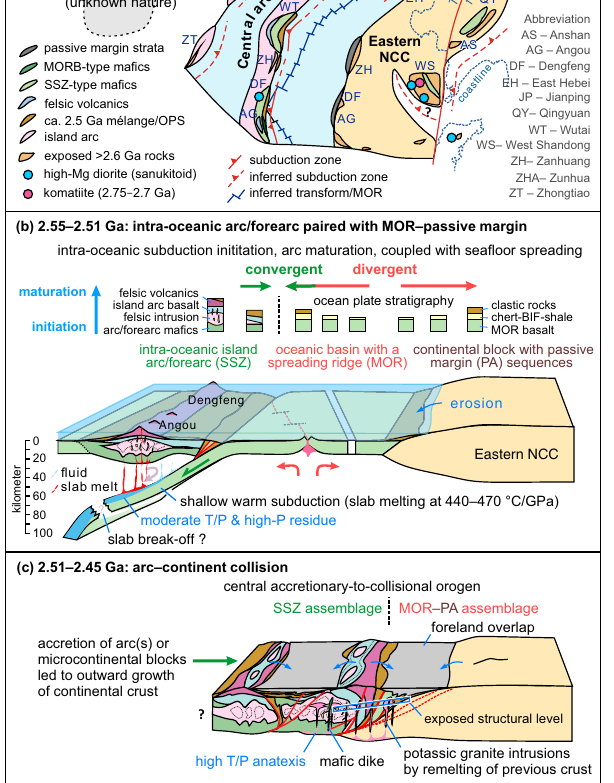
Fig. 6 | Reconstructed late Neoarchean tectonic model for the southern North ChinaCraton.a PalinspasticreconstructionoftheProto-NorthChinaCratonatca. 2.53Ga. Subduction-related geological records are widely distributed along the Central arc system 18,19,44 . Passive continental margin sequences were deposited discontinuously along the southwesternmargin of the Eastern North China Craton (Eastern NCC, or the Eastern Block) 18,19,44 . The geological units have been restored across the sinistral Tanlu fault following ref. 73. b 2.55 – 2.51Ga: Intra-oceanic sub- ductioninitiationandarcmaturationinthewest,pairedwithasubductingslabthat originated from a spreading mid-ocean ridge, and with passive margin sedi- mentation in the Angou – Dengfeng segment of the Proto-North China Craton.